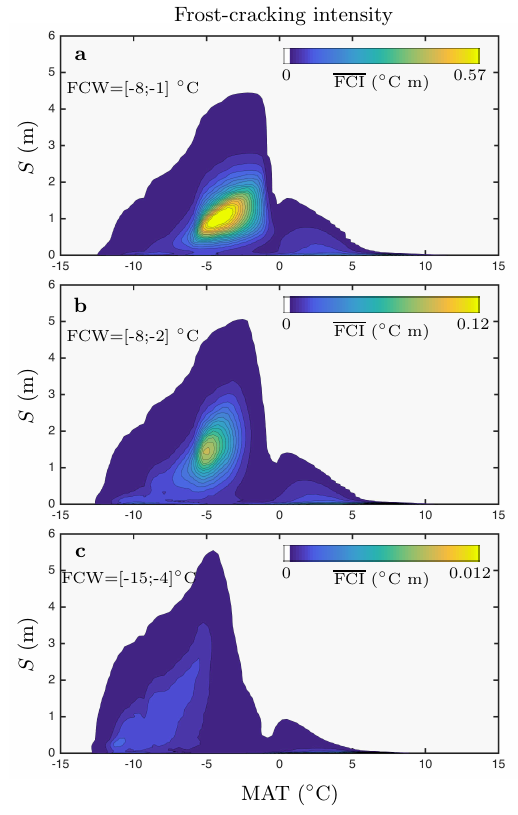
Figure 12. Integrated frost-cracking intensity as a function of sediment thickness and MAT, for frost-cracking windows of (a) [ − 8; − 1], (b) [ − 8; − 2], and (c) [ − 15; − 4] ◦ C. Note the different colour